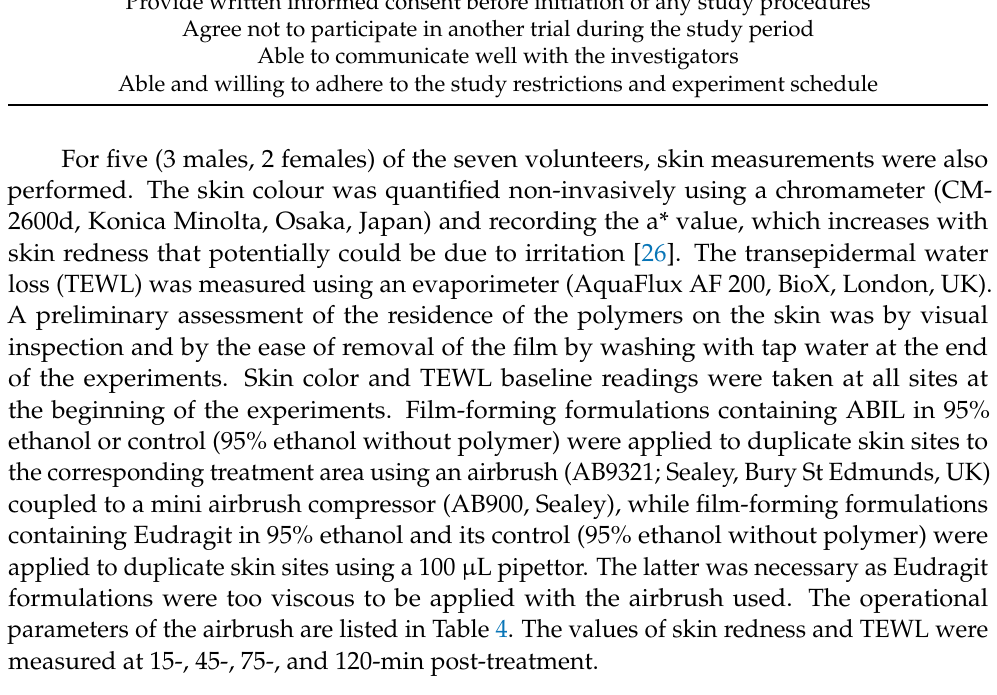
Table 4. Operational parameters of